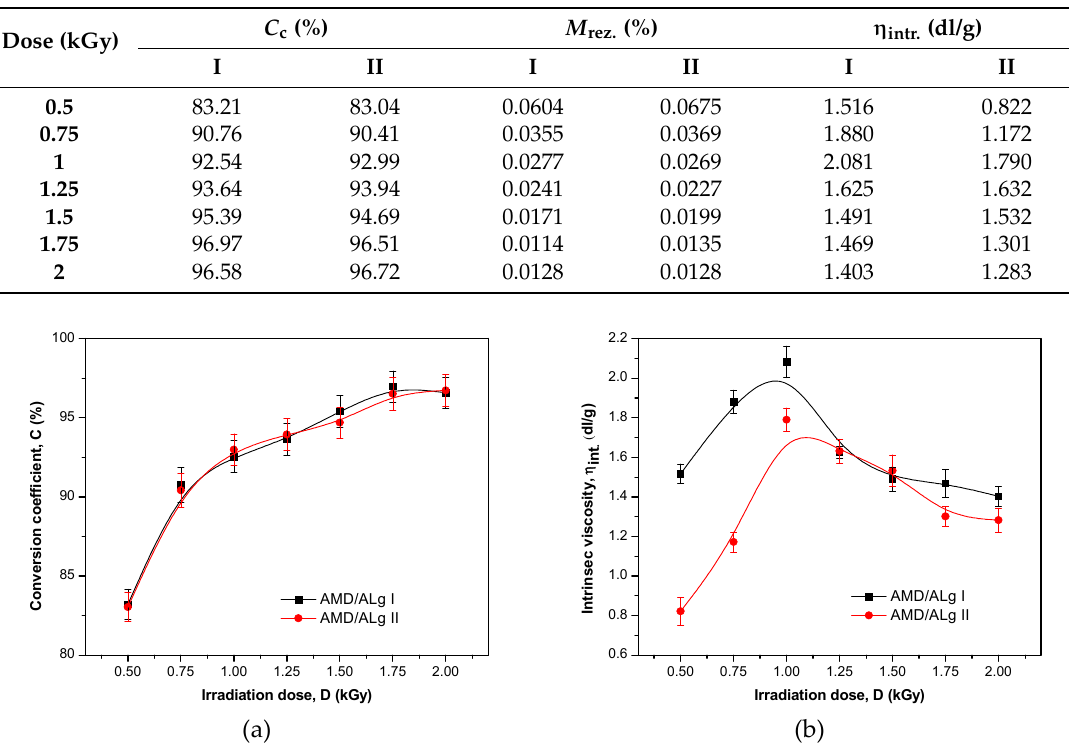
Figure 1. Conversion coefficient ( a ) and intrinsic viscosity ( b ) versus electron beam irradiation dose for AMD/ALg I and AMD/ALg II polymer types.